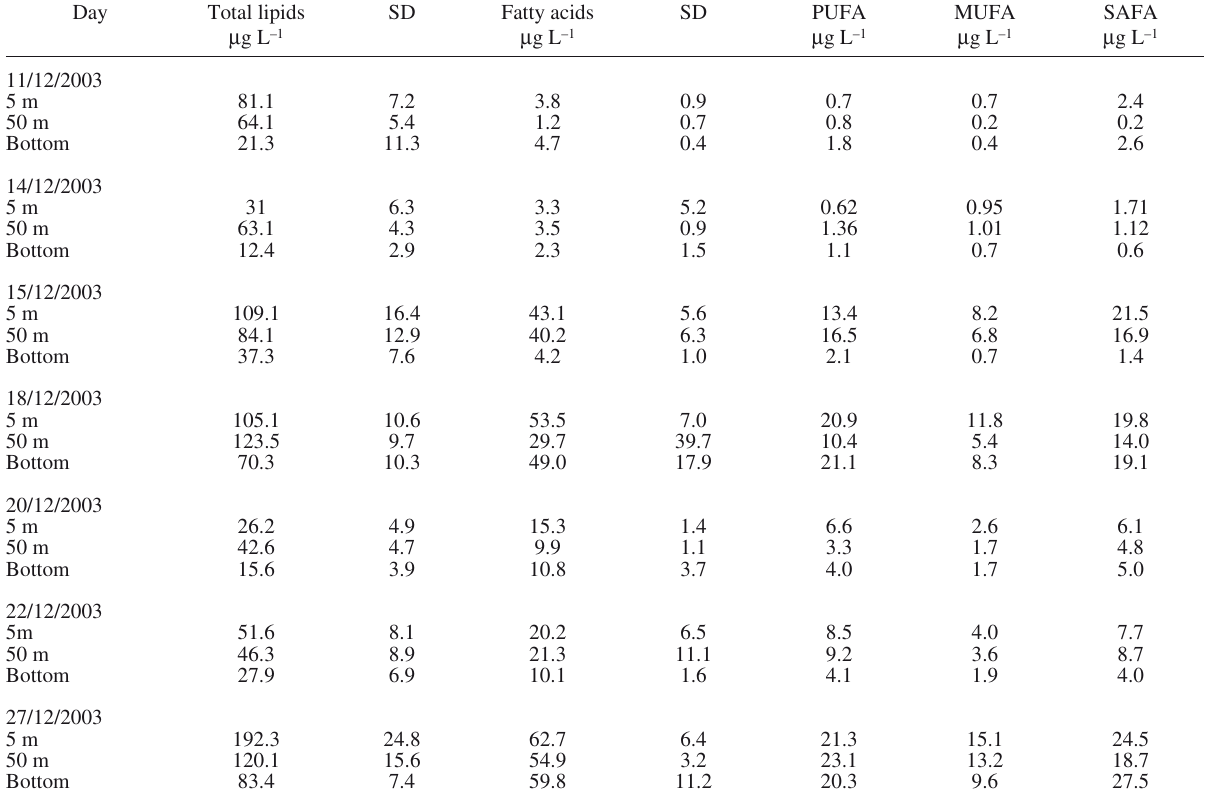
Fig . 2. – Fatty acid proportion (%) of the total lipid concentration at the three sampled depths (5, 50 and around 450 m) in the water column from 11 to 27 December Table 2. – Total lipid and fatty acid concentration ( m g L -1 ) in the water column (5 m, 50 m and near-bottom water layers) during the sampling period (Mean ± SD). SD, standard deviation. SAFA, saturated fatty acids; MUFA, monounsaturated fatty acids; PUFA, polyunsaturated fatty acids.